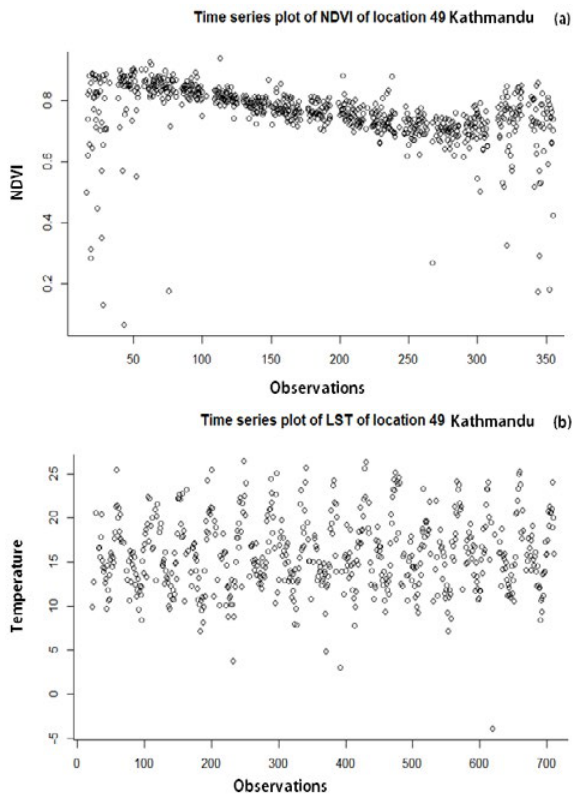
Fig. 4. Time series plot of NDVI (a) and LST Fig. 4: Time series plot of NDVI (a) and LST (b)